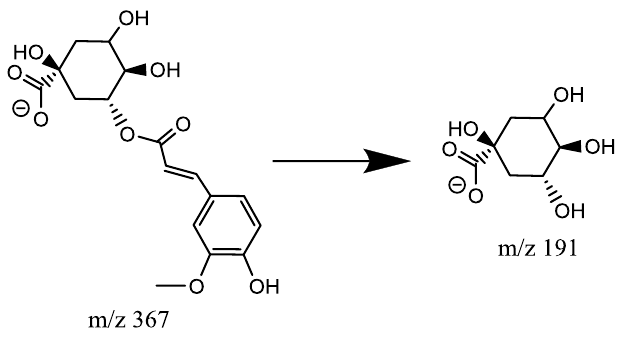
Figure 6 . Fragmentation pathways of 5-FQA